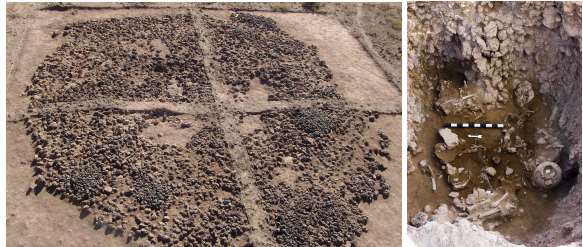
Figure 4. Burial Nr 3 of Nerqin Naver before and during excavations